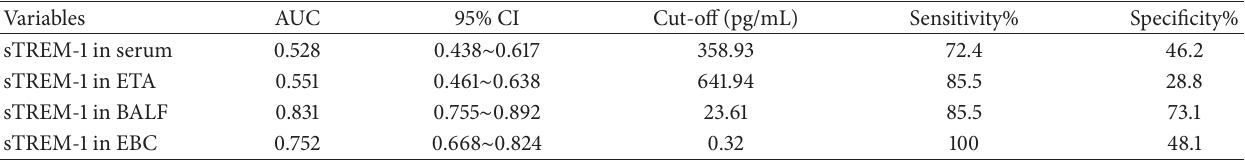
Table 2: Best cut-off values of sTREM-1 that were obtained from ROC curves for VAP diagnosis.